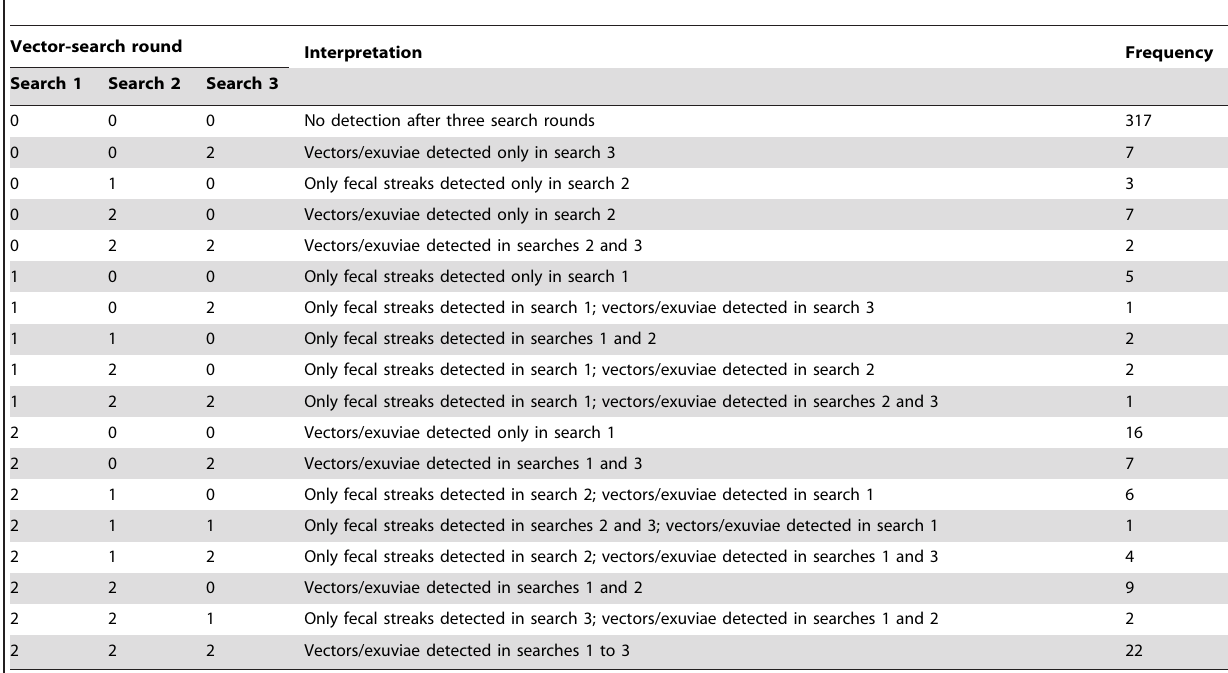
Table 2. Chagas disease vector ‘detection histories’ in 414 man-made ecotopes of the lower Jaguaribe valley in northeastern Brazil across three vector-search rounds: code, interpretation, and individual history frequencies.